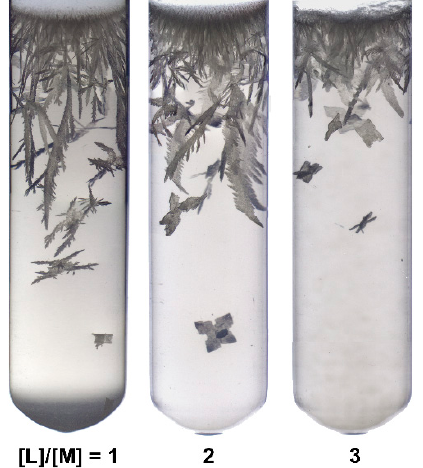
Figure 7. Crystallization trials close to equilibrium performed by using the two layers-gel technique at [L] + [M] = 28 mM and varying [L]/[M] ratios (M = Cd 2+ ; L = bpp). All the crystals belong to the 1D- cha phase. The number of crystals and the depth at which they form decrease while increasing the ligand to metal molar ratio. Only the half of the tubes filled with gel are